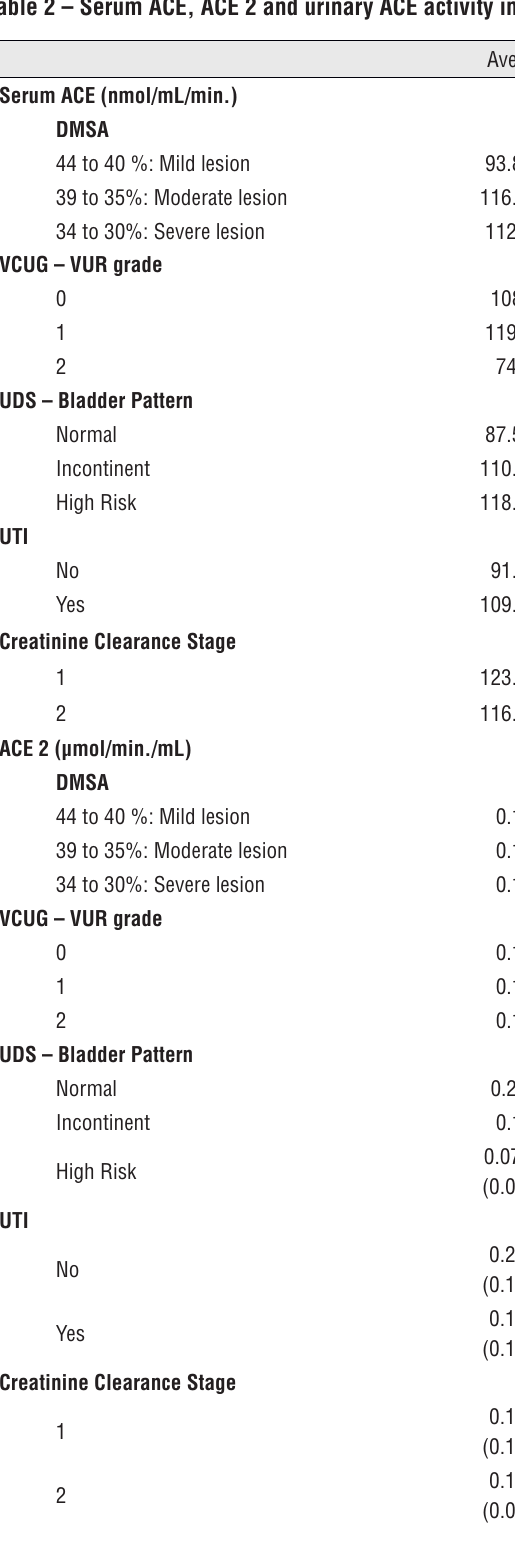
Table 2 – Serum ACE, ACE 2 and urinary ACE activity in Study Group.